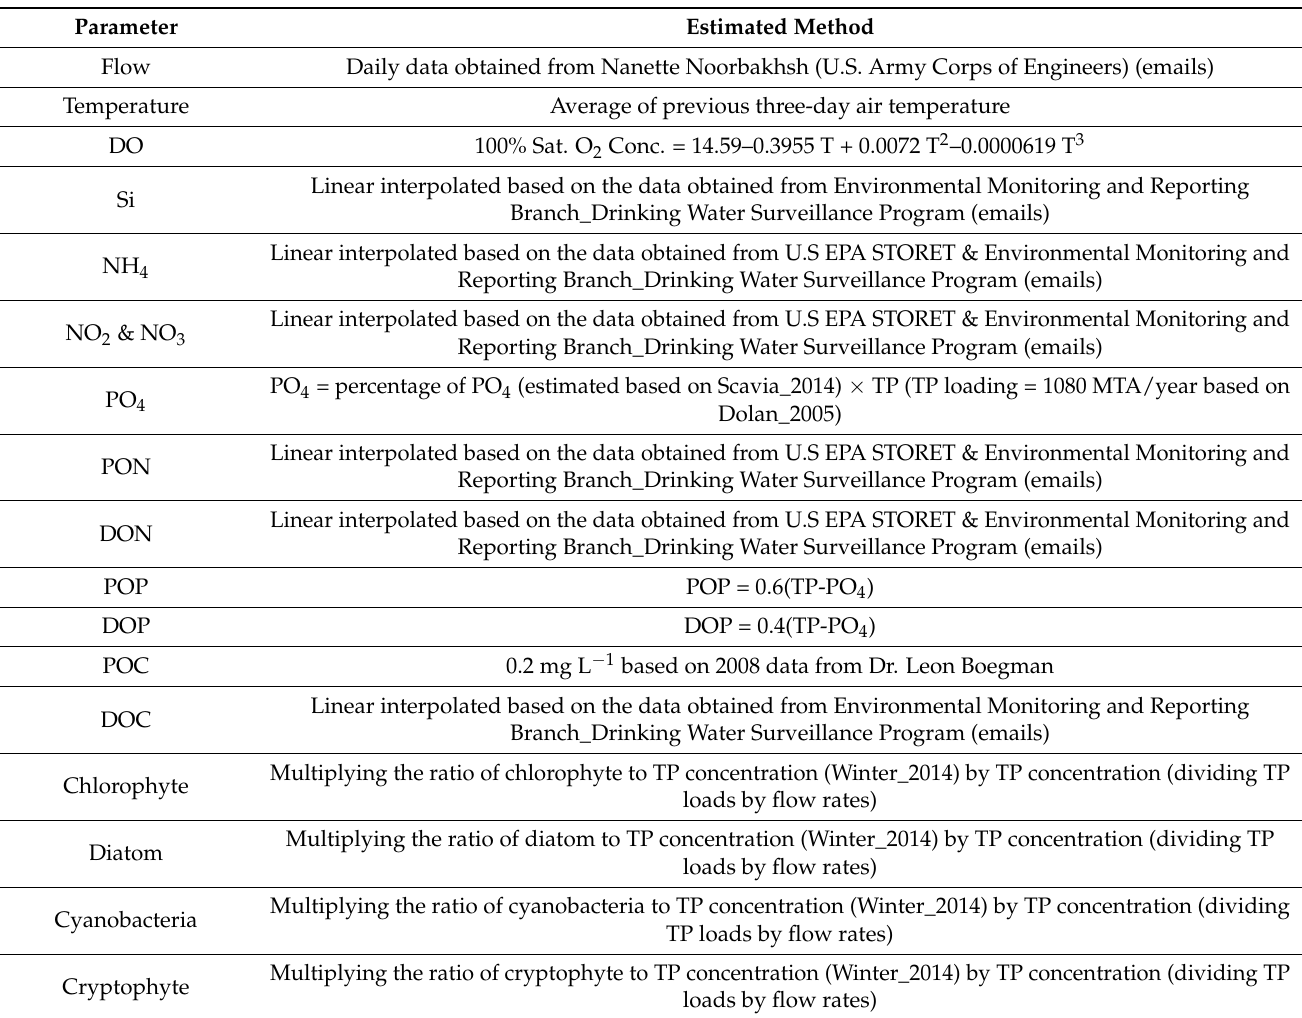
Table A1. Summary of Water Quality Data Sources of the Detroit